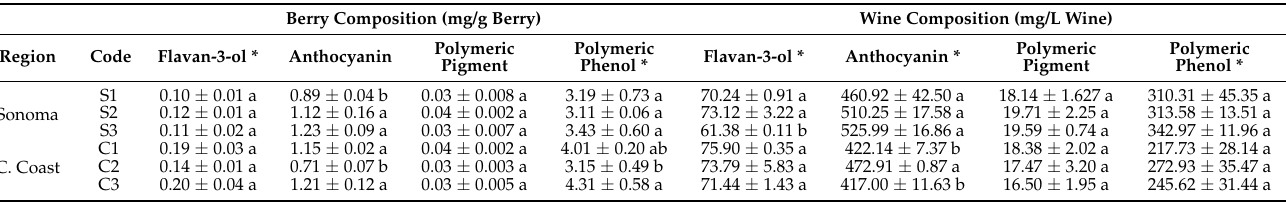
Table 2. Grape and wine phenolic